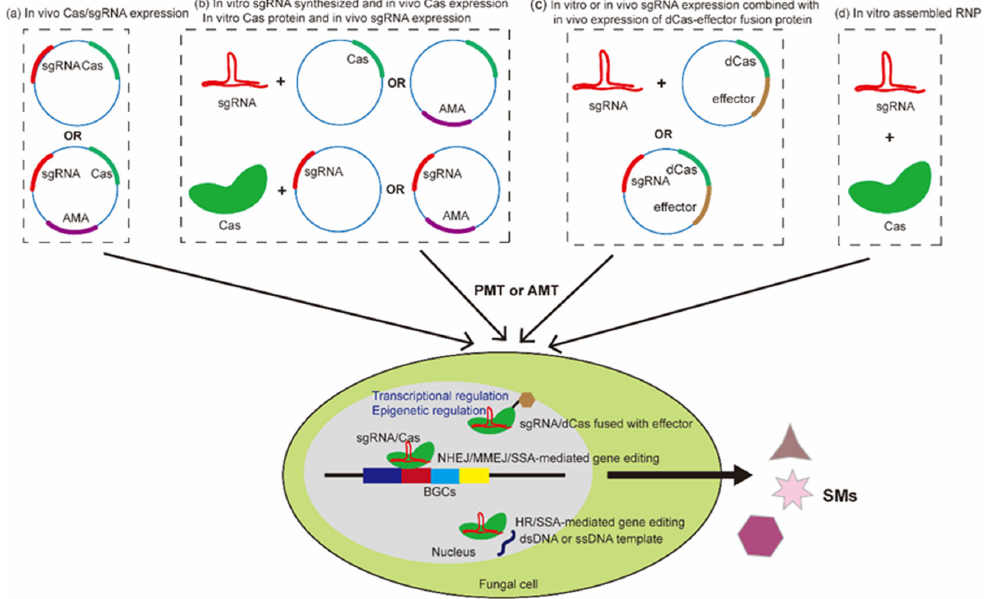
Figure 2. An overview of the application of CRISPR/Cas technology in fungi. The expression of Cas and gRNA can be achieved via several strategies. ( a ) In vivo expression of Cas and gRNA in the form of a plasmid or self ‐ replicating AMA plasmid. ( b ) Cas and gRNA are expressed in a combined way, including in vitro synthesized gRNA and in vivo Cas expression, and in vitro Cas expression and in vivo gRNA expression. ( c ) CRISPR/dCas ‐ based gene regulation and epigenetic editing, achieved via a gRNA/dCas–effector complex which is formed in vitro or in vivo expressed gRNA and a deactivated Cas (dCas)–effector fusion protein. ( d ) Cas and gRNA can both be ex- pressed in vitro to form an RNP complex. An AMA plasmid is used for recycling selection